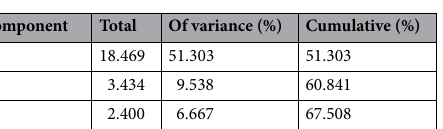
Table 6. Three principal component eigenvalues and variance